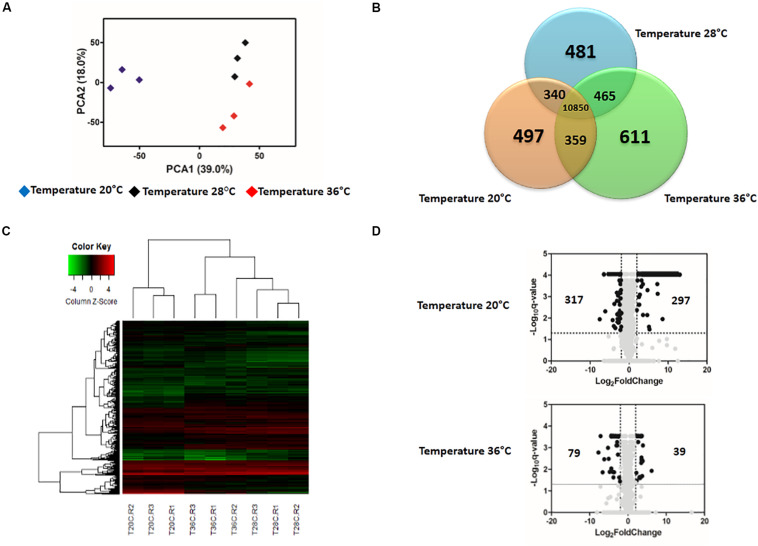
Effect of temperature in the expression profile of uninfected blood-fed Aedes aegypti.
(A) Principal Component Analysis (PCA) plot showing the global gene expression profiles. (B) Venn Diagram reporting the number of specific and shared genes. (C) Heatmap plot showing local differences (naming scheme: TC20R1 = replicate 1 for the temperature 20°C). (D) Volcano plot representing the differential gene expression in RNAseq samples from Ae. aegypti exposed to three different constant temperatures (20, 28, and 36°C) at 48 h.